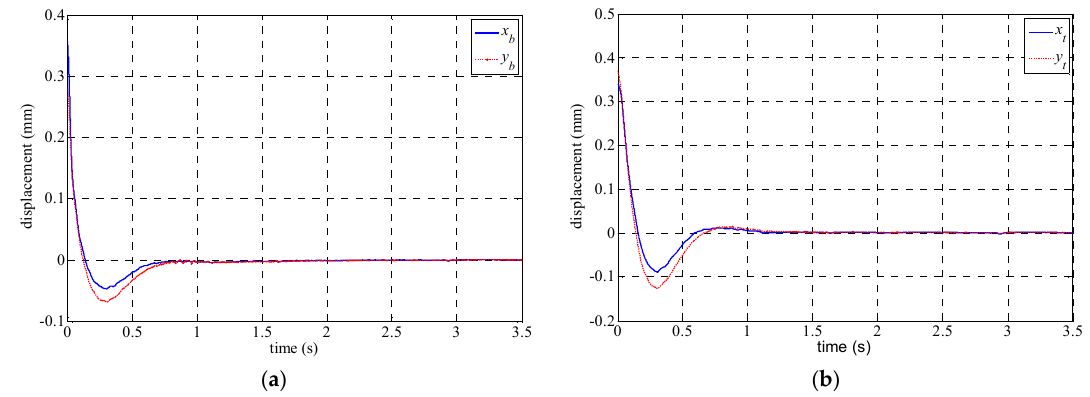
Figure 18. Experimental results: ( a ) displacement y b and y b ; and ( b ) displacement x t and y t .